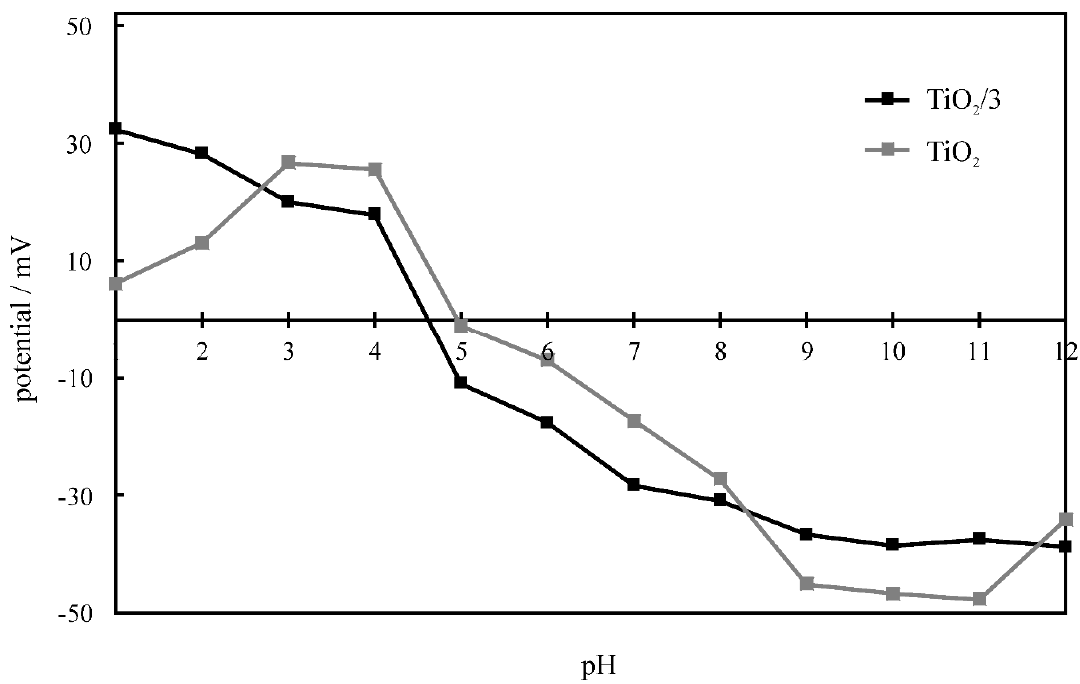
Figure 7. The efficiencies of phenol and methylene blue photocatalytic degradation in the presence of TiO 2 and the given composites.